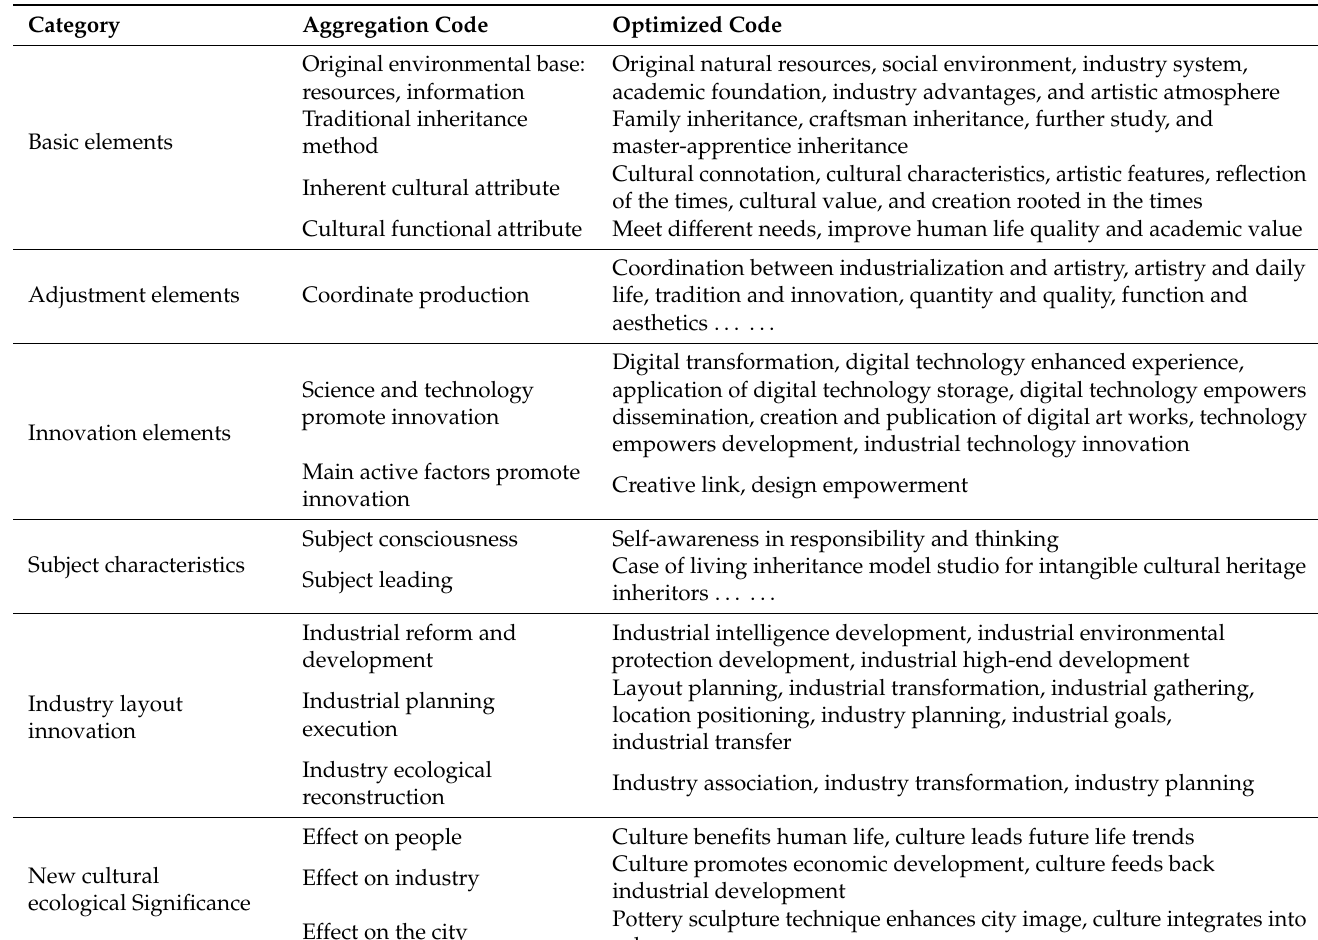
Table 3. Focused coding analysis results of Shiwan pottery sculpture technique’s effective text (some